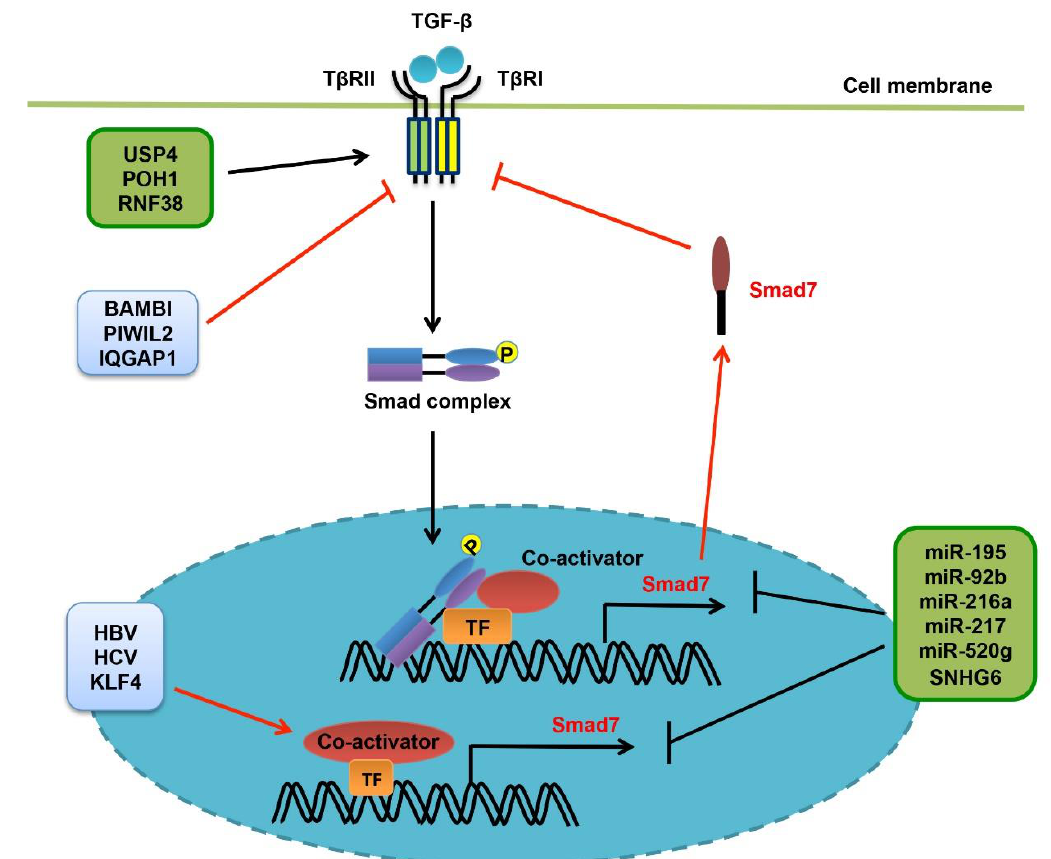
Figure 4. Regulation of TGF- β receptors. Smad7 has been recognized as a central hub in regulating TGF- β receptors, acting via feedback loops and multiple mechanisms. Therefore, regulation of Smad7 gene expression by HBV / HCV, the transcription factor KLF4 or some miRNAs, is rational to modulate the activity of TGF- β receptors in liver cancer. Importantly, deregulated Smad7 leads to altered TGF- β signaling, which is closely associated with liver tumorigenesis, in a context-dependent manner. In addition, the deubiquitylating enzymes USP4 and POH1 could directly interact with and stabilize T β RI. RNF38 also enhances T β RI protein stability by targeting AHNAK. On the contrary, BAMBI, PIWIL2 and IQGAP1 are able to inhibit the activity of TGF- β receptors.